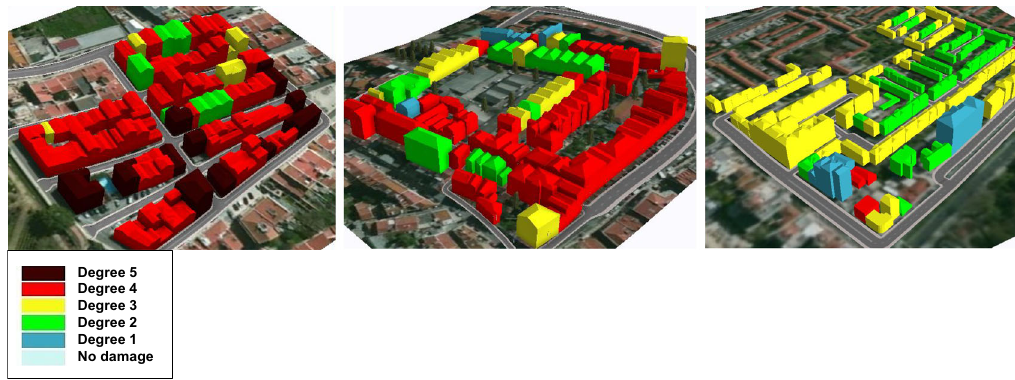
Fig. 9 Simulation of near source earthquake with intensity IX in the pilot areas: Ajuda (left), Grac¸a (middle), and